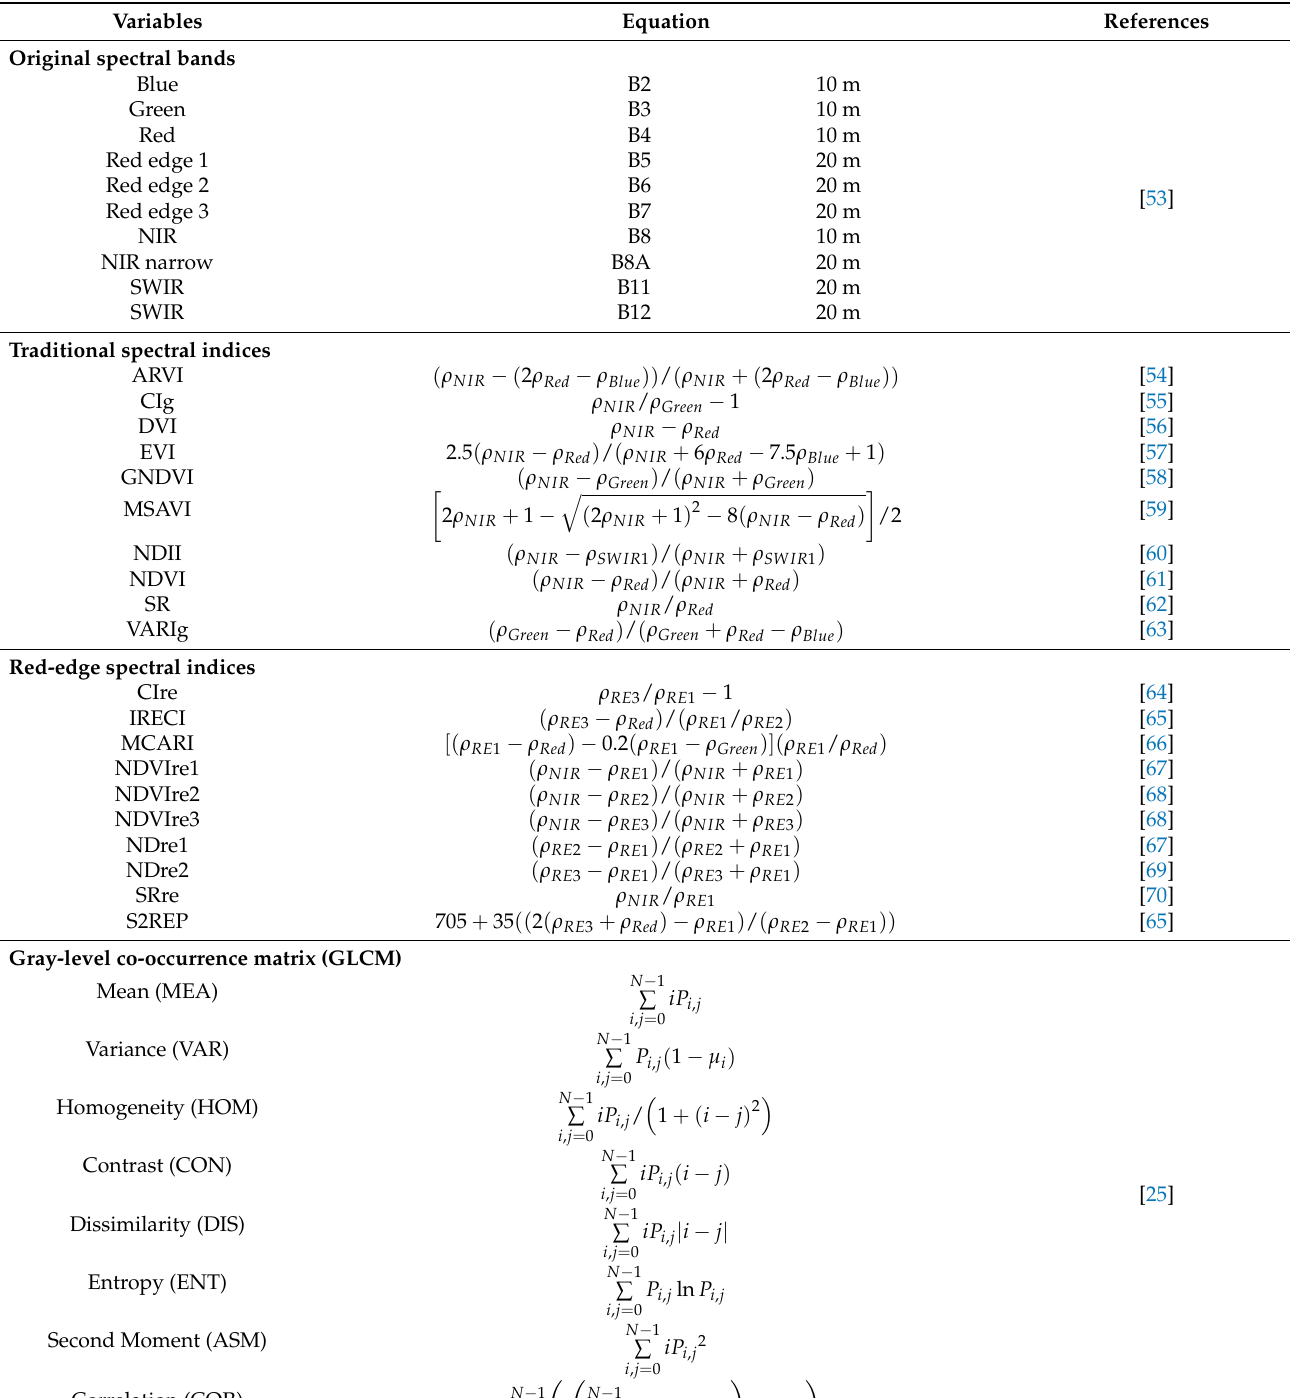
Table 1. Description and formula of input variables, including raw bands, traditional and red-edge vegetation indices, and textures, derived from Sentinel-2A MSI for modeling AGB in this